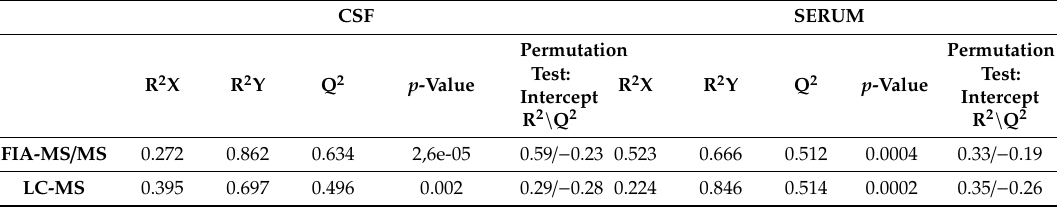
Figure 1. Multivariate analysis. A – B : PLS-DA models resulted from the analysis of cerebrospinal fluid (CSF) samples with FIA-MS / MS and LC-MS. C – D : PLS-DA models resulted from the analysis of serum samples with FIA-MS / MS and LC-MS. Black circles indicate primary progressive MS (PPMS) patients while white boxes indicate RRMS patients. The statistical parameters were all significant and were reported in the Table 1. Table 2. Statistical parameters of the multivariate models resulting from the analysis of the matrix generated by FIA-MS / MS and LC-MS